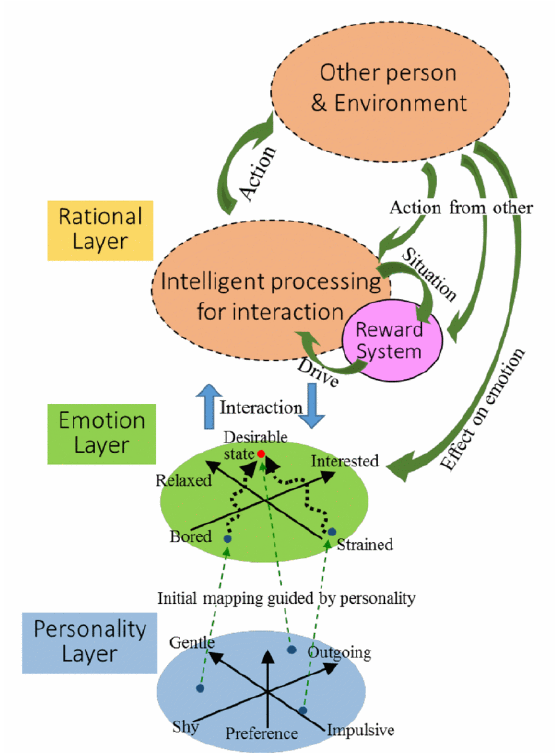
Figure 18. Model of emotion-based strategic interactions (Reprinted with permission from Ref. [6], 2015, T.